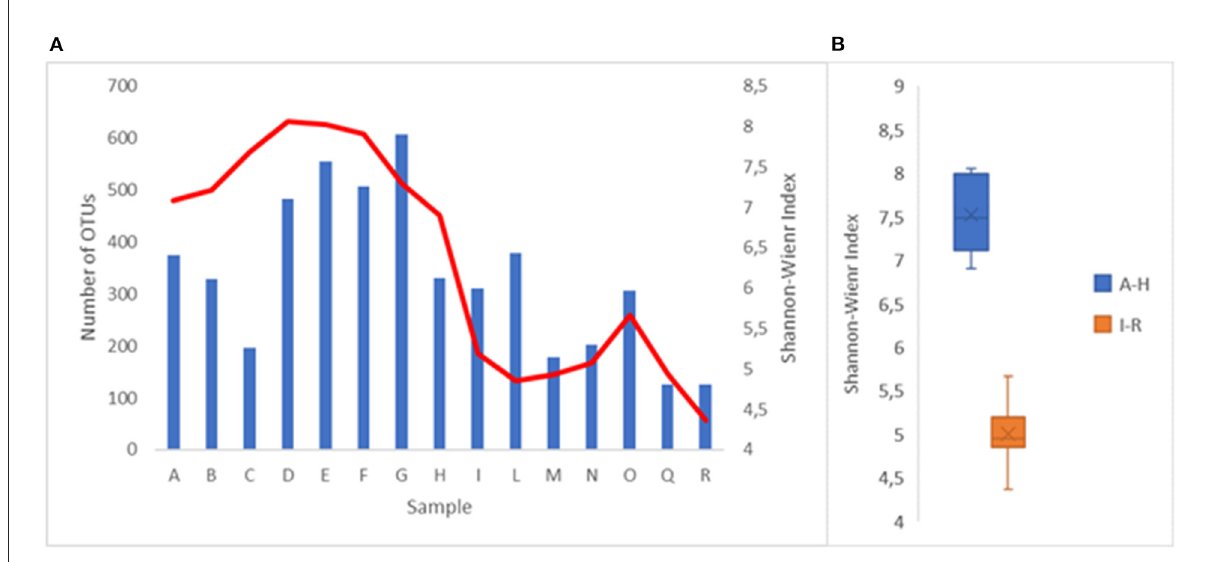
FIGURE1 (A) Number of OTU’s (blue bar) and Shannon-Wiener index (red line) at the different withdrawal points. (B) Representation of the Shannon-Wiener index values in the sampling points A–H and